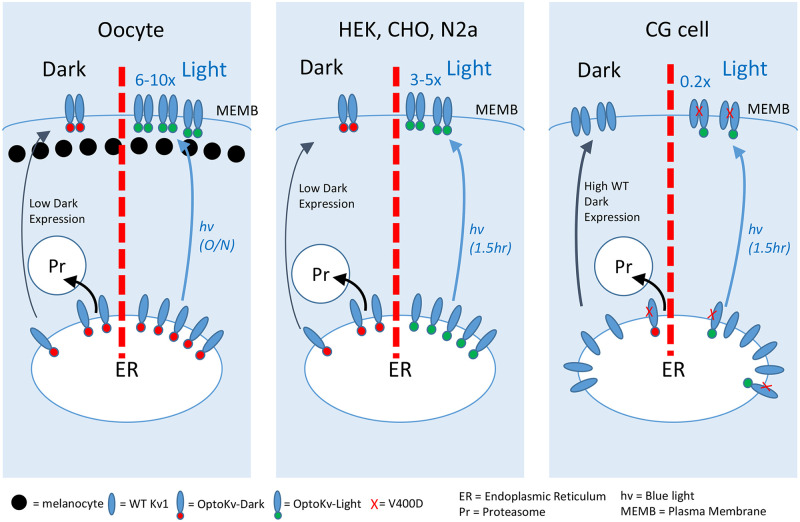
Expression of Opto-Kv channels in different expression systems.In the dark, Opto-Kv channel monomeric subunits are retained by the endoplasmic reticulum (ER) by trafficking machinery and shuttled for degradation because the inactive LOV domain (red) disrupts T1-dependent tetramerization and channel assembly. Upon blue light (hv) exposure, activated LOV do-main (green) frees the T1 domain to tetramerize, allowing fully assembled channels to easily traffic to the surface. (left panel) In Xenopus oocytes, blue light increases Opto-Kv current approximately 10-fold after overnight exposure at 18°C. (center panel) Blue light exposure for 1.5 hours is sufficient to rapidly increase surface expression about 3-5-fold by greatly increasing the fraction of tetrameric channels. This increase plateaus possibly due to limited subunit availability due to degradation of unassembled subunits prior to light exposure. (right panel) Neurons are making wild type channels but unassembled Opto-Kv-DN channels are shunted to degrade. Blue light treatment for 1.5 hours allows Opto-Kv-DN subunits to co-assemble with wild type dropping currents by 80%. Large effect is due to ability of one Opto-Kv-DN subunit to disrupt three wild type subunits.